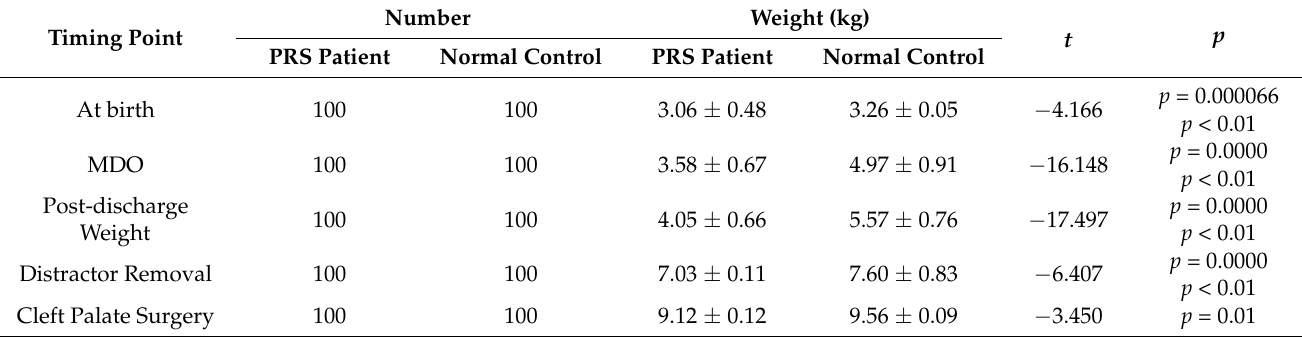
Table 2. Weight Comparison Between PRS Patients Undergoing MDO and Normal Controls.